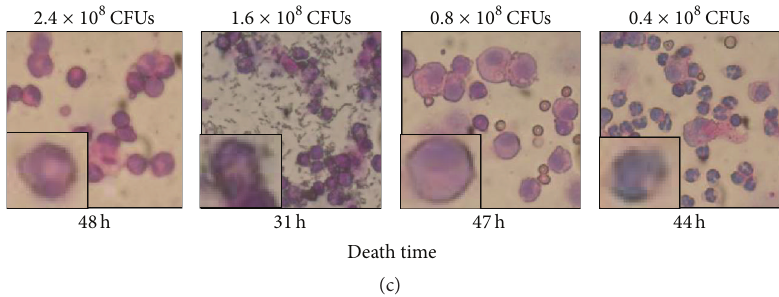
Figure 2: Morphologies of peritoneal lavage cells (PLCs) from mice infected intraperitoneally with E. coli . ICR mice were infected intraperitoneally with 3 doses of E. coli or received saline and then sacrificed at 18, 48, and 72 hours, respectively, for harvesting their PLCs. The PLCs were stained with H&E dye followed by taking photos and counting cell numbers under a microscope. (a) Photos of PLCs from killed mice. (b) The cell counts based on the PLC morphologies. (c) Photos of PLCs from dying mice. Each group is composed of 6